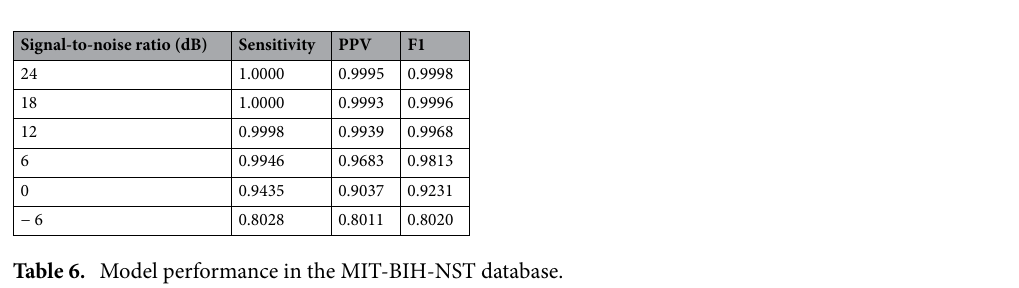
Table 6. Model performance in the MIT-BIH-NST database.